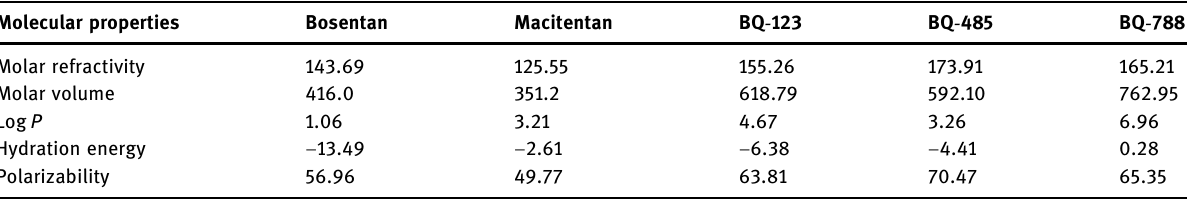
Table 4: Molecular and QSAR properties of the known ET - I antagonists Molecular